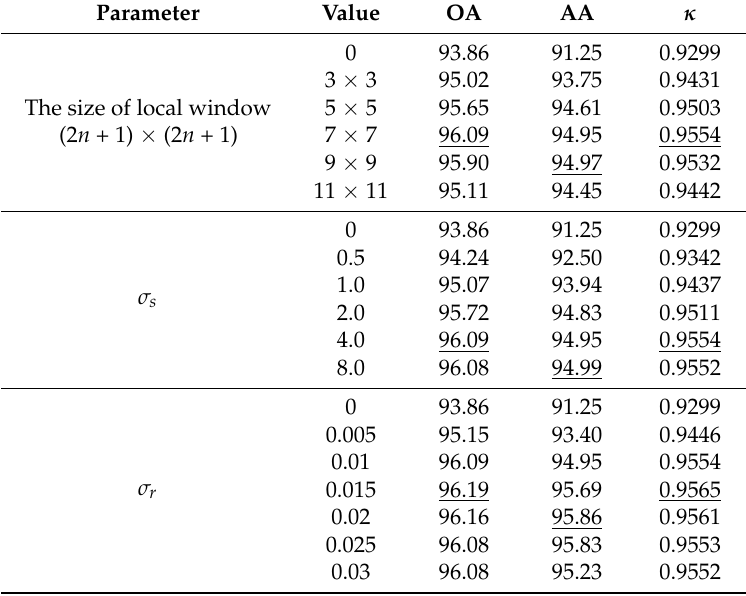
Table 5. The impact of different parameter settings on classification accuracies using the CS-GC + JBF method for the Indian Pines data set. The highest accuracies are indicated in underlined in each